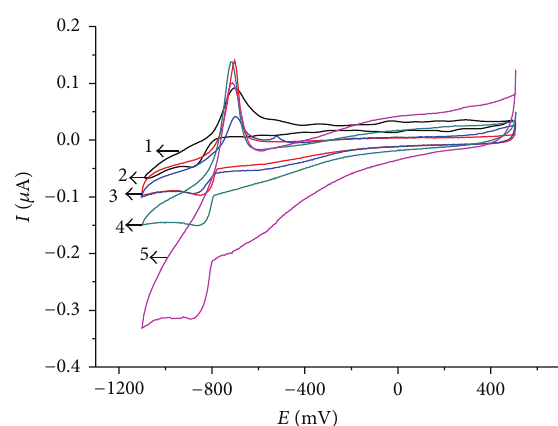
Figure 6: Cyclic polarization curves on the glassy carbon electrode at different temperatures in the presence of oxygen. Conditions as given in Figure 4. (1) 25 ∘ C, (2) 35 ∘ C, (3) 45 ∘ C, (4) 55 ∘ C, and (5) 65 ∘